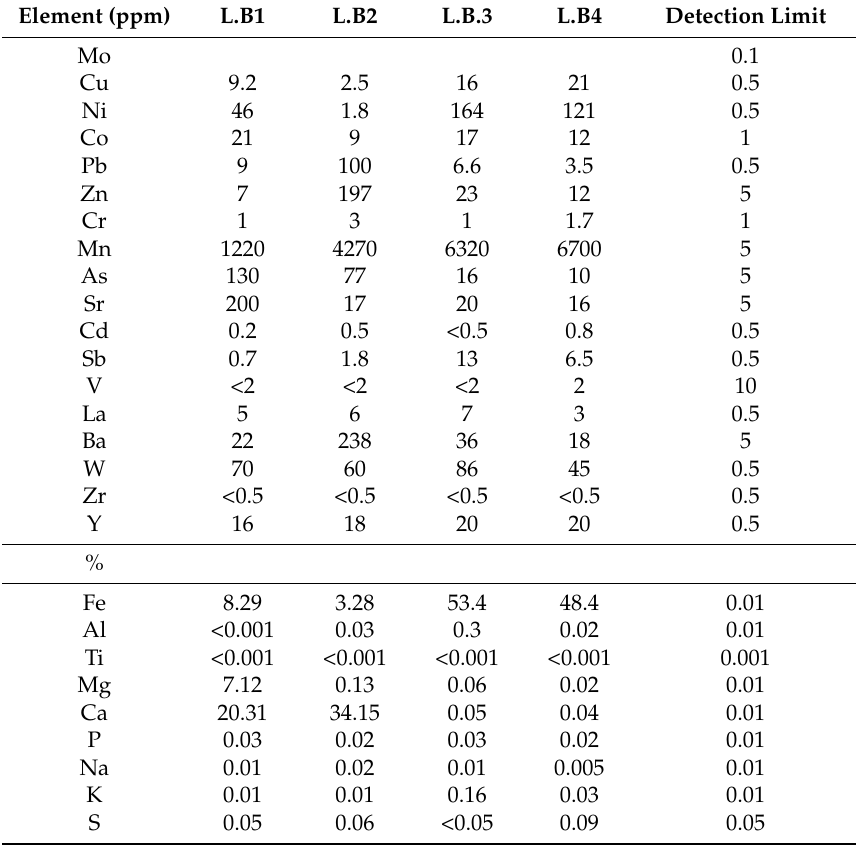
Table 3. Representative bulk analyses of Fe-Mn mineralized samples from the the Legrena valley,